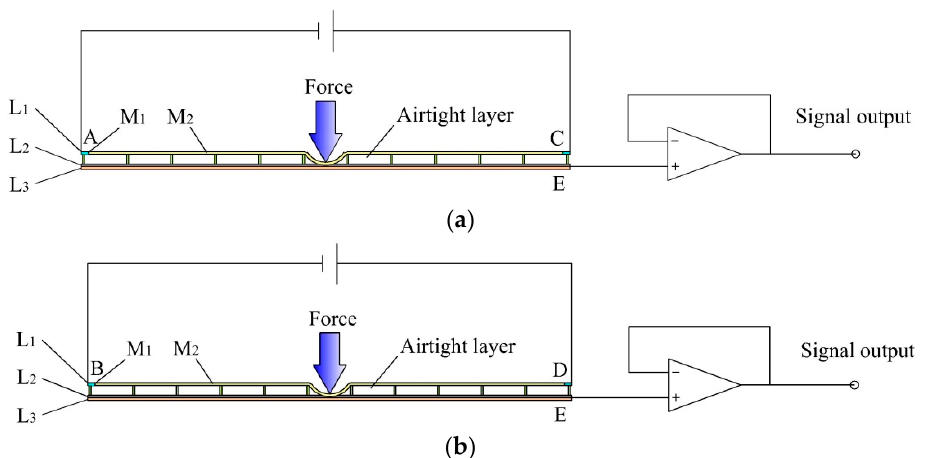
Figure 5. Position detection. ( a ) Position detection in the X -axis. ( b ) Position detection in the Y -axis.